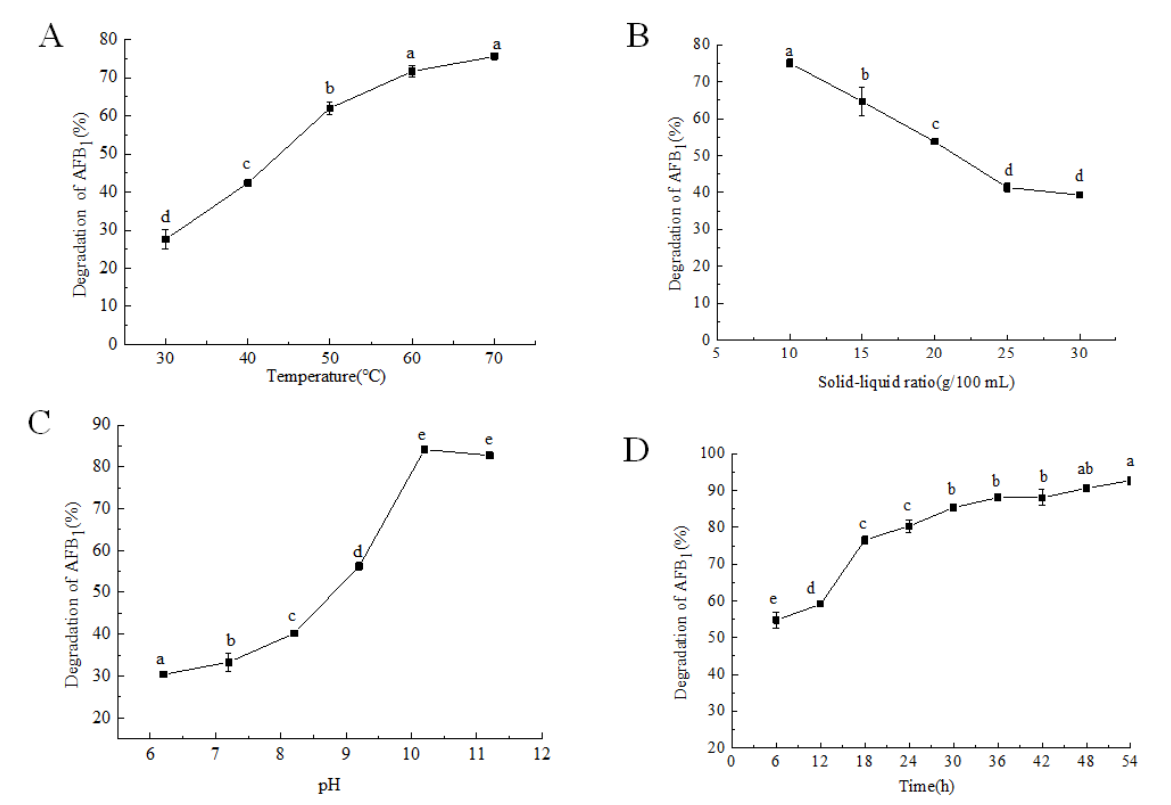
Figure 1. Effect of various factors on the degradation of AFB 1 in moldy maize by fermentation supernatant. Note: ( A – D ) represent the effects of temperature, solid-liquid ratio, pH, and time on the degradation of AFB 1 , respectively. The different lowercase letters in each figure indicate significant differences ( p < 0.05).